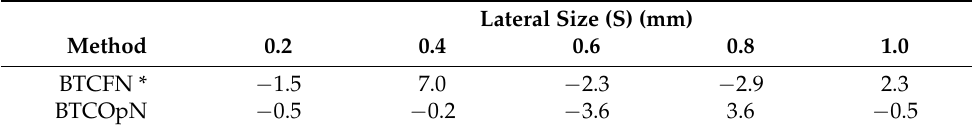
Table 10. Relative percent error (%) for ROI-d detected in maxigrams of actual thermal sequences processed by the BTCFN and BTCOpN methods ( S = 15